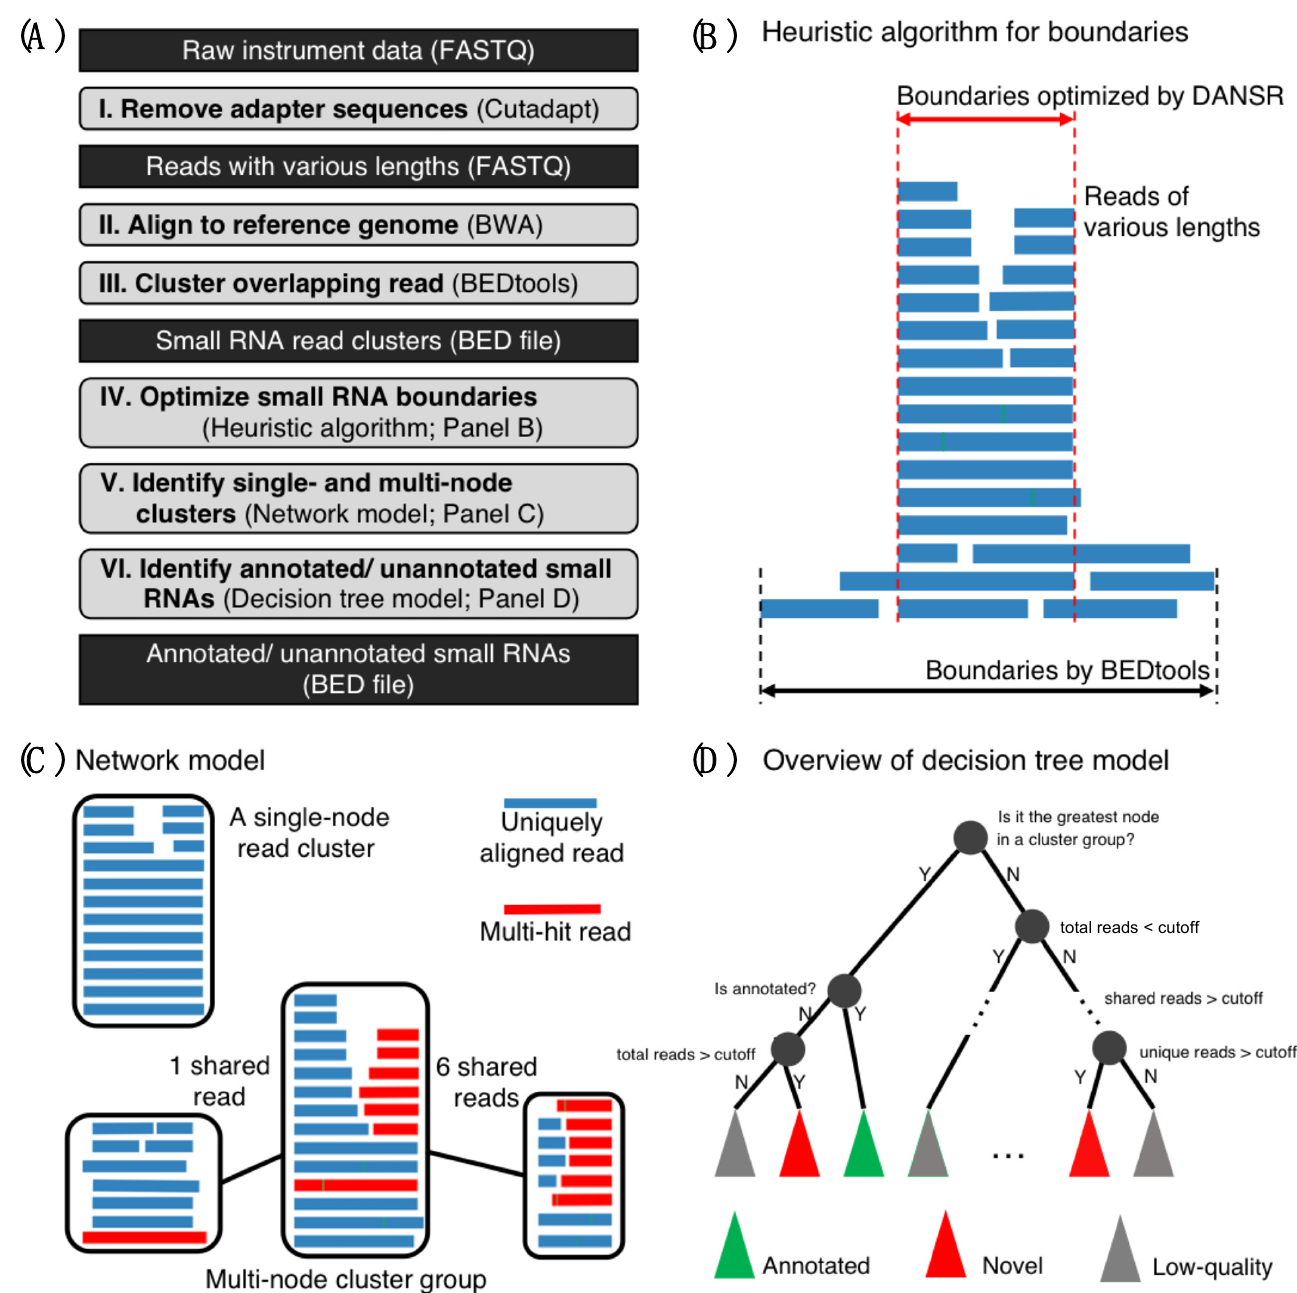
Figure 1. Optimized small noncoding RNA discovery and quantification tool, DANSR. ( A ) Workflow of the DANSR tool. DANSR consists of six steps for identifying and estimating small noncoding RNA expression. DANSR does not have any limitations on read length or size of small noncoding RNAs. ( B ) Improvement in small noncoding RNA boundary estimation. Sequencing reads are assigned a weight based on support from overlapping reads and low-weight reads are excluded to improve small noncoding RNA boundary discovery. ( C ) Network analysis of read clusters. A net- work is used to identify single-node read clusters and multi-node read clusters (group of clusters). ( D ) Overview of decision tree model to analyze read cluster networks (see Figure S3 for full detail). Low-quality, false positive read clusters are filtered and annotated and novel small noncoding